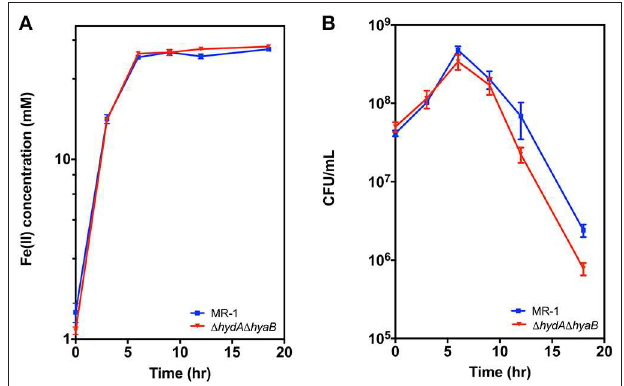
FIGURE 5 | Survival of MR-1 is enhanced compared to 1 hydA 1 hyaB . Strains were grown in vented bioreactors with Fe(III) citrate (50mM) as the terminal electron acceptor and lactate (10mM) as electron donor. Cultures were monitored over time for (A) Fe(II), and (B) cell density measured as colony forming units (CFU). Data represents three independent cultures with error reported as